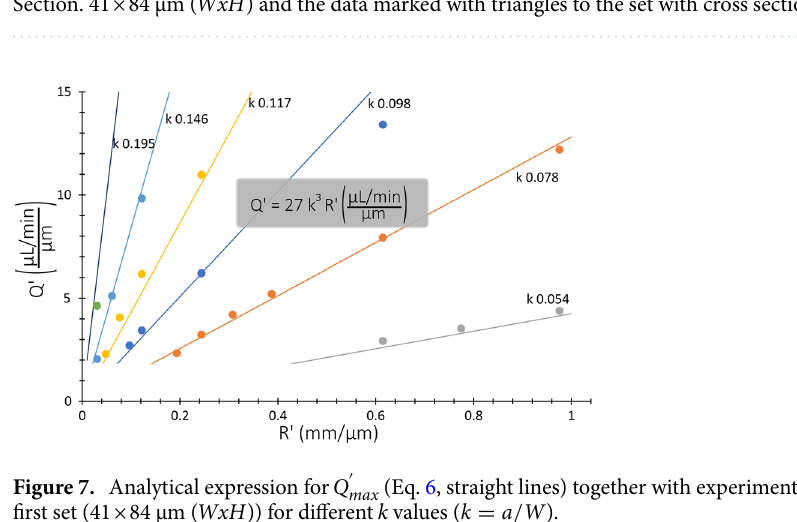
Figure 6. ( A ) Experimental data of Q max obtained with microchannels consisting of two loops, fixed R and 41 × 84 µm ( WxH ). ( B ) Experimental data of Q max from both sets expressed with generalized variables, Q ′ Q / W , R ′ R / W and k a / W . The data marked with circles corresponds to the set with cross = = = Section. 41 × 84 µm ( WxH ) and the data marked with triangles to the set with cross section 10.5 × 22 µm ( WxH ).